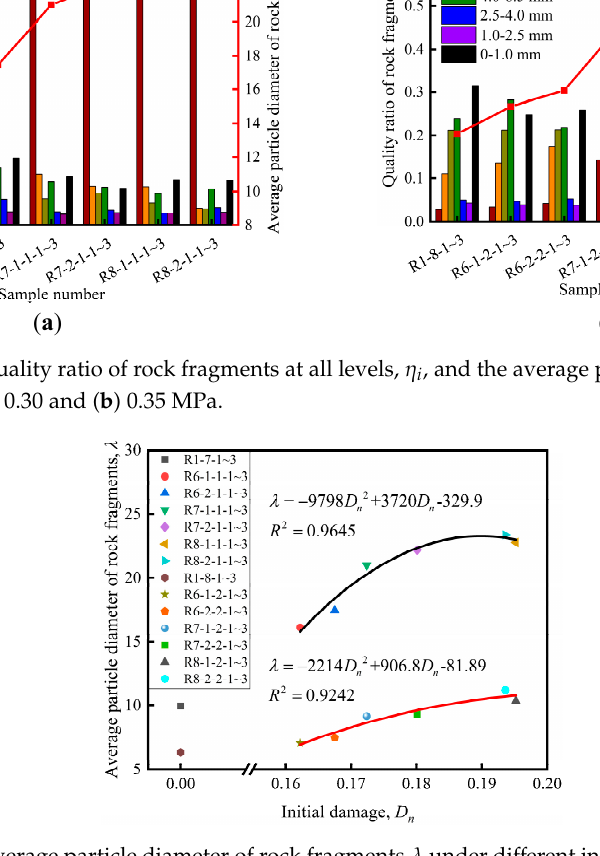
Figure 19. The average particle diameter of rock fragments conditions.